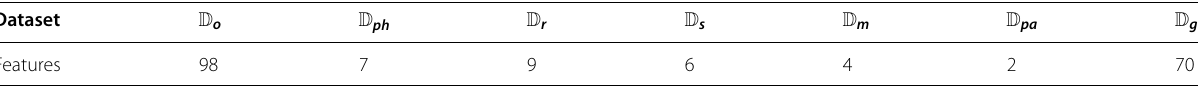
Table 1 Features and